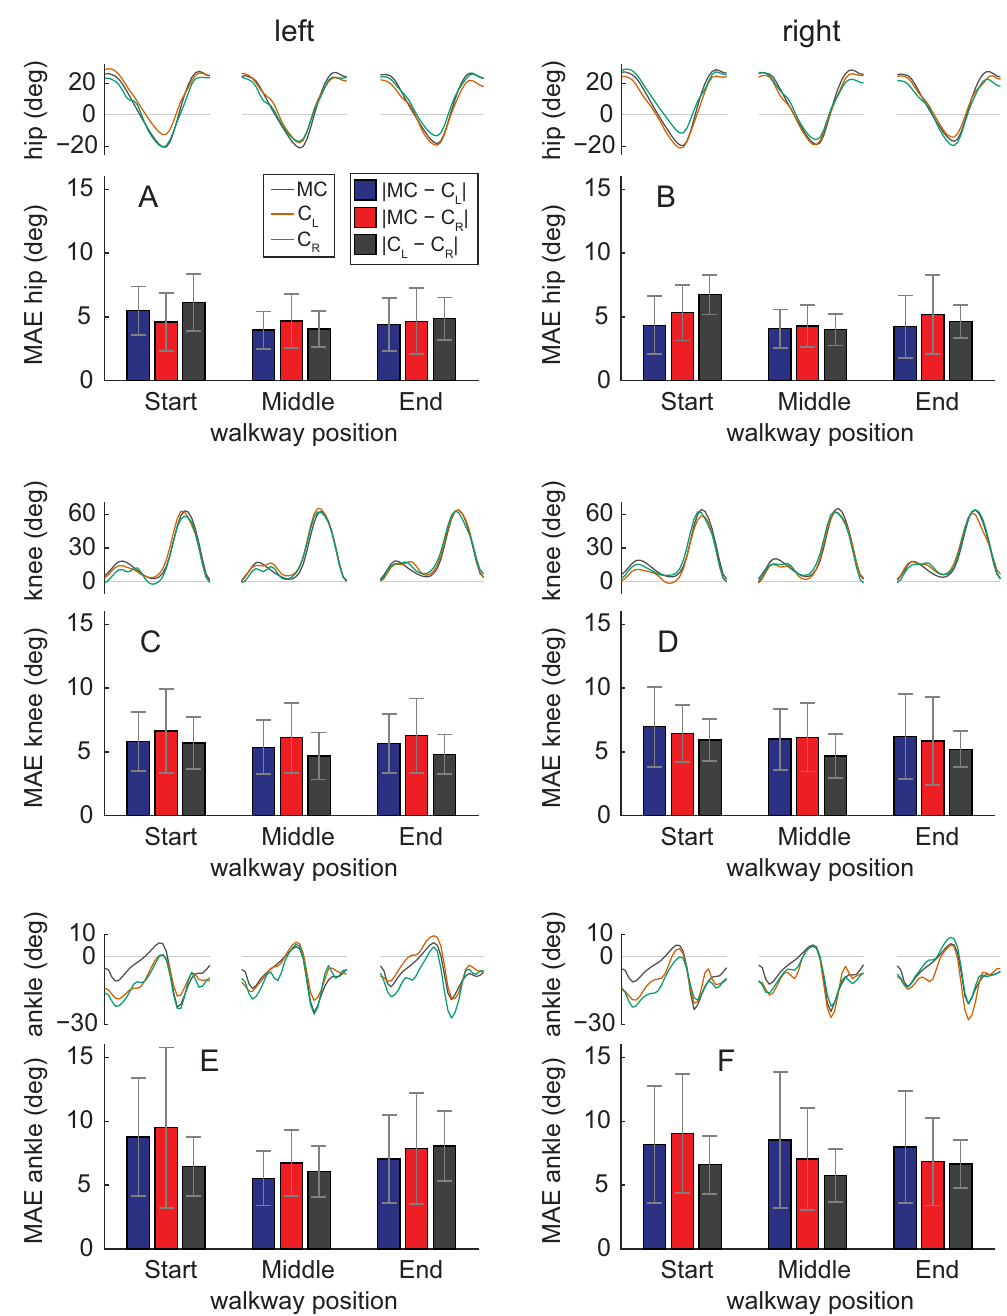
Fig 8. Effect of walkway position on sagittal plane joint angles. Comparisons of joint angles and mean absolute error (MAE) between measurement systems at three portions of the walkway. The portions were based on the average anterior- posterior position of the C7 marker in motion capture data throughout each gait cycle. Gait cycles were binned in regions: ‘Start’ spanning anterior-posterior positions less than − 0.50 m of the middle of the walkway, ‘Middle spanning position from − 0.50 to 0.50 m, and ‘End’ spanning positions greater than 0.50 m. The number of gait cycles analyzed were 30, 22 and 24 for ‘Start’, ‘Middle’ and ‘End’, respectively, for the left leg and 31, 21 and 26 for the right